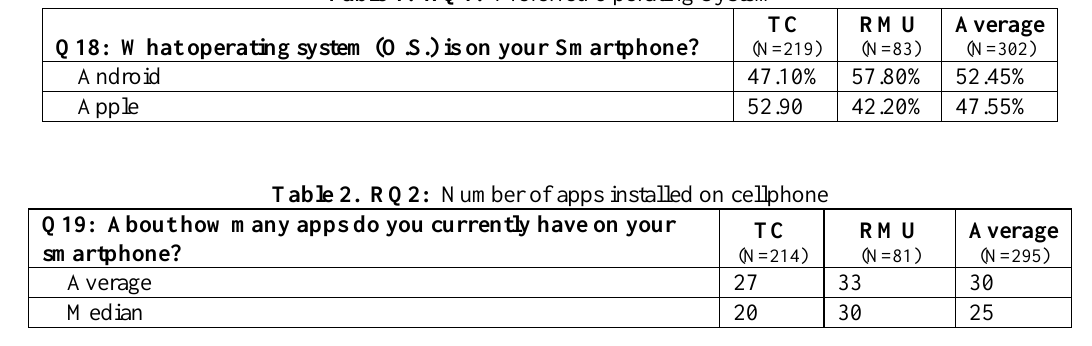
Table 3. RQ3: Most useful app